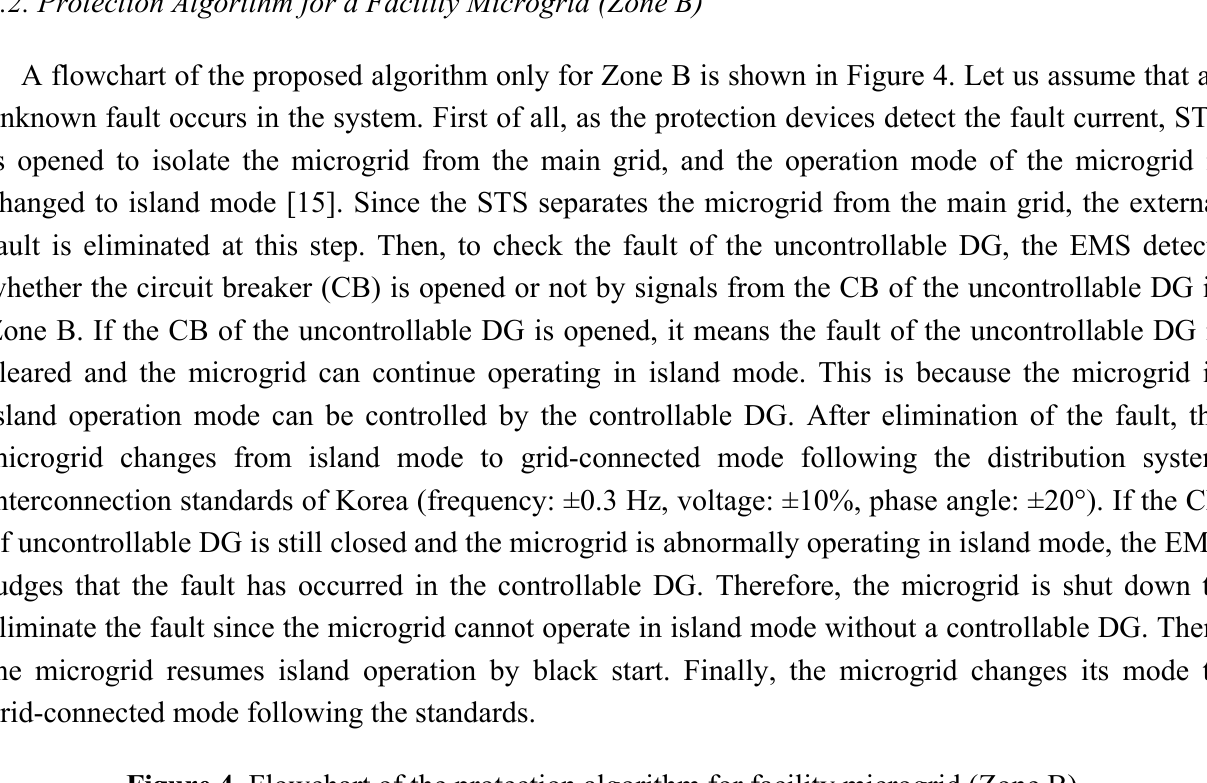
Figure 4. Flowchart of the protection algorithm for facility microgrid (Zone